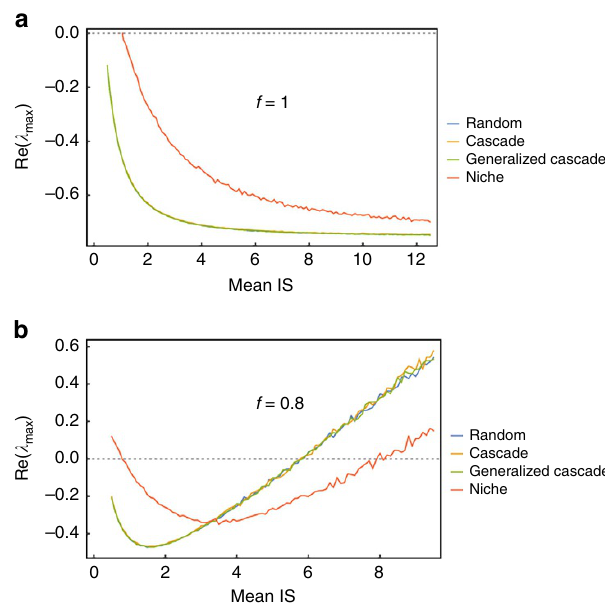
Figure 3 | Consistent Stability Pattern for Changing Network